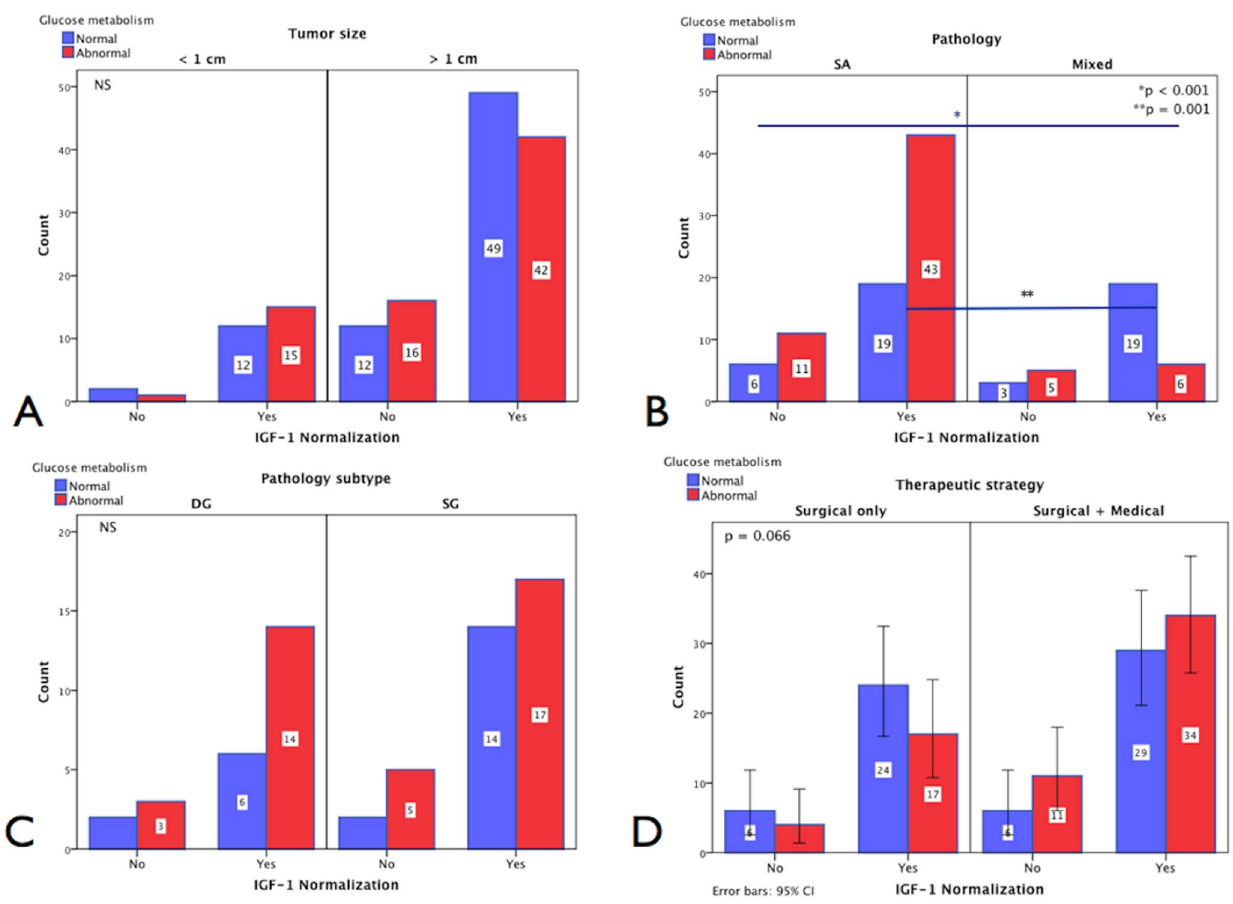
Figure 3. Glucose metabolism and IGF-1 normalization. A. IGF-1 and glucose metabolism according to pituitary tumor size. From the group of patients with microadenomas (n=30), 12 [40.0%] cases with normal and 15 [50.0%] with abnormal glucose metabolism reached IGF-1 normalization compared with 2 [6.5%] with normal and 1 (3.2%) with abnormal metabolism who did not reach IGF-1 normalization (NS); whereas in the macroadenomas group, 49 [41.5%] with normal and 42 [35.6%] with abnormal glucose metabolism normalized IGF-1 vs. 12 [38.7%] with normal and 16 [51.6%] with abnormal glucose metabolism did not [N=149] (NS). B. IGF-1 and glucose metabolism according to pituitary pathology. Six [24.0%] somatotroph adenomas showed normal vs. 11 [44.0%] abnormal glucose metabolism and 3 [12.0%] mixed